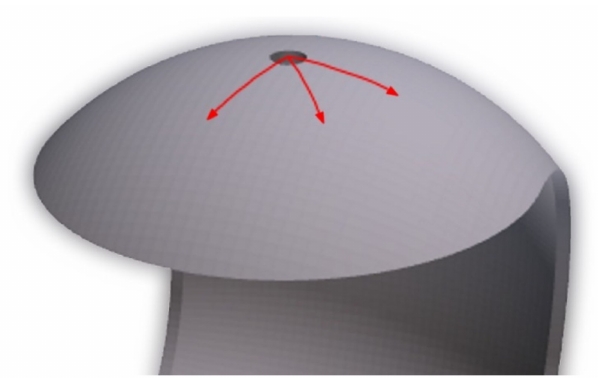
Figure 5. Scheme for roughness measurements, taken at the top, middle and bottom face of the